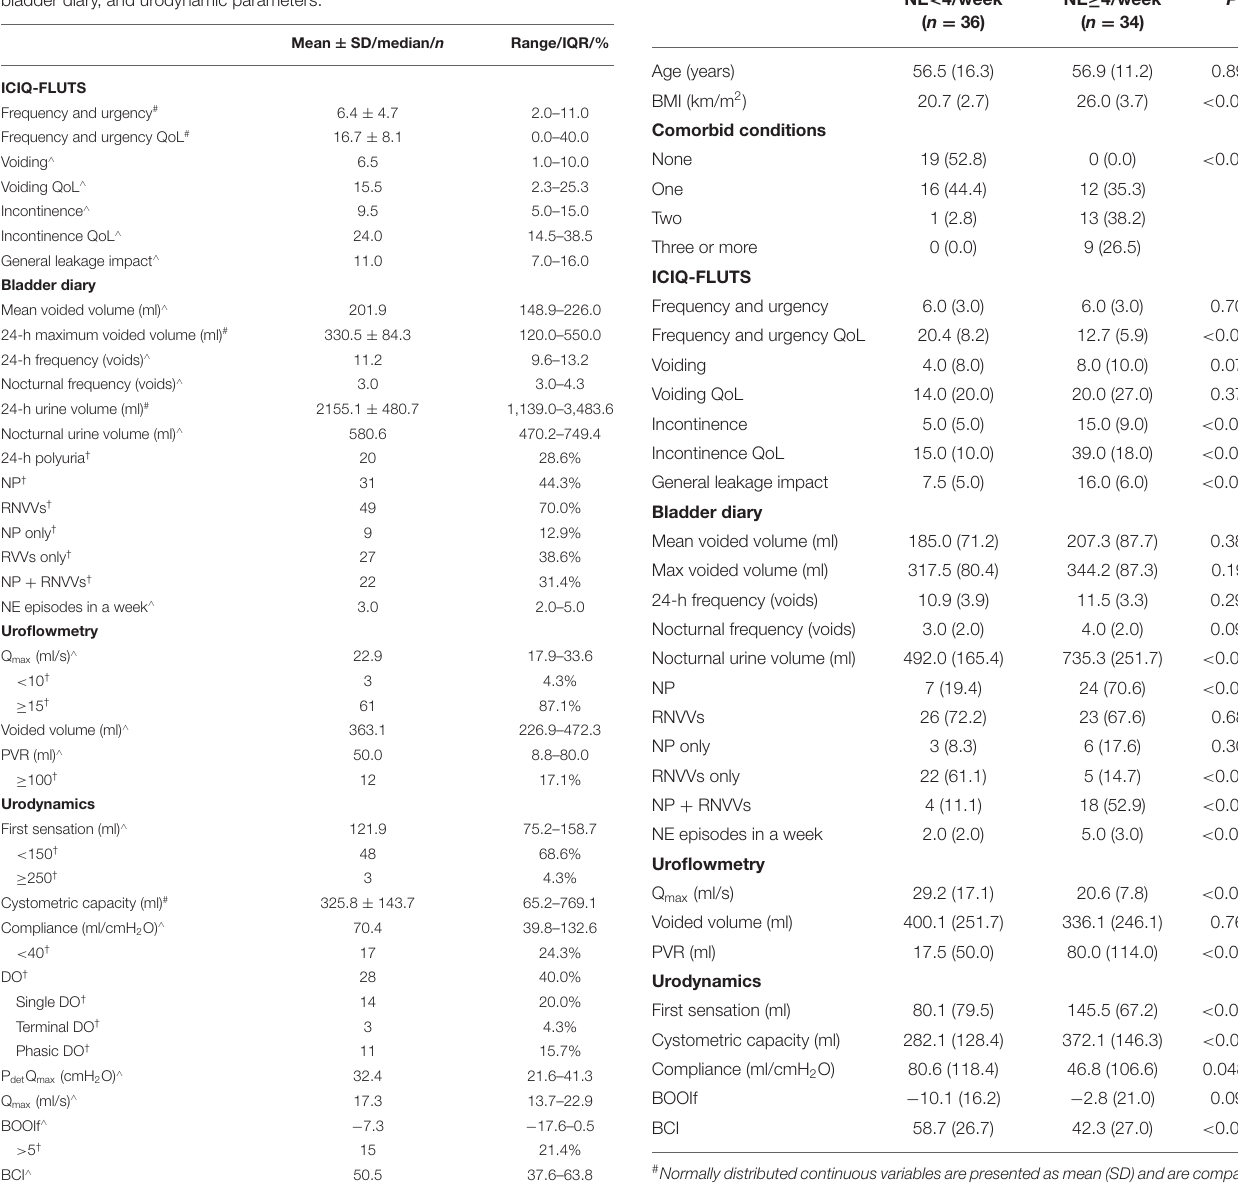
TABLE 2 | International Consultation on Incontinence Modular Questionnaire—female lower urinary tract symptoms (ICIQ-FLUTS) scores, bladder diary, and urodynamic parameters.